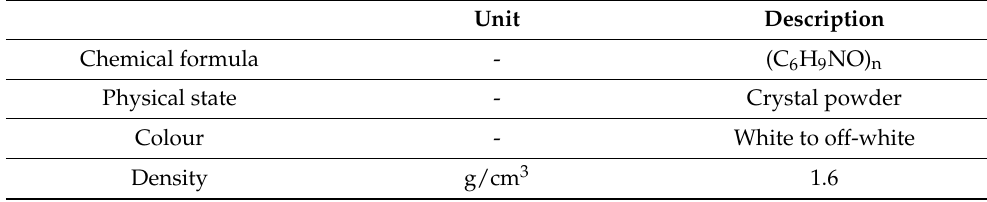
Table 3. Physical properties of PVP as the surfactant.